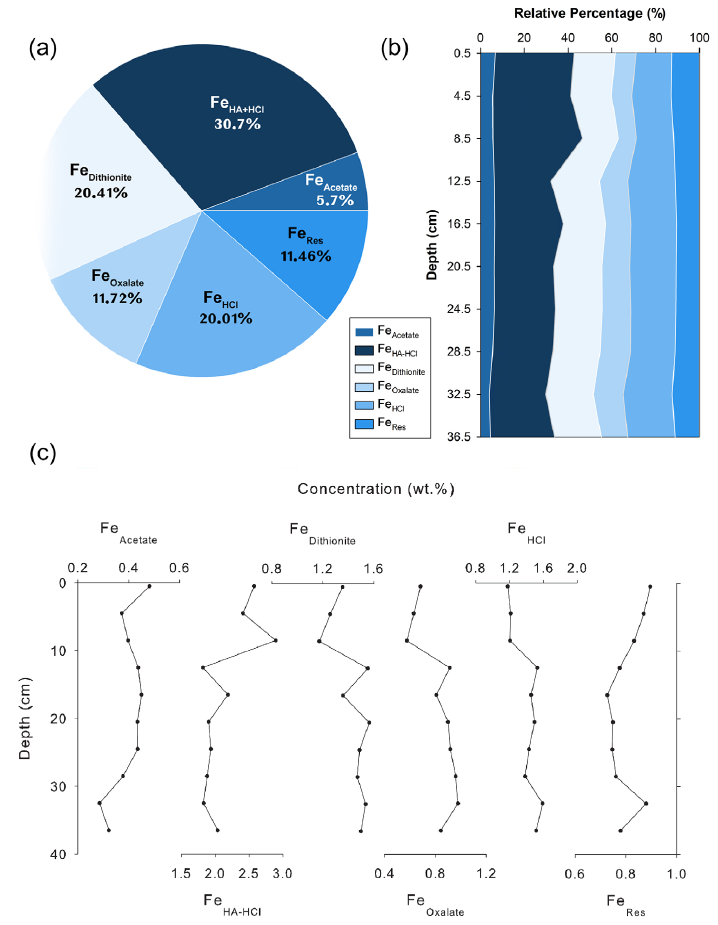
Figure 7. ( a ) Phase partitioning of different sedimentary iron species in the sediment core based on average data. ( b ) Relative percentages of solid Fe phases with sediment depth. ( c ) Down-core vari- ation of different Fe phases (units in wt.%).